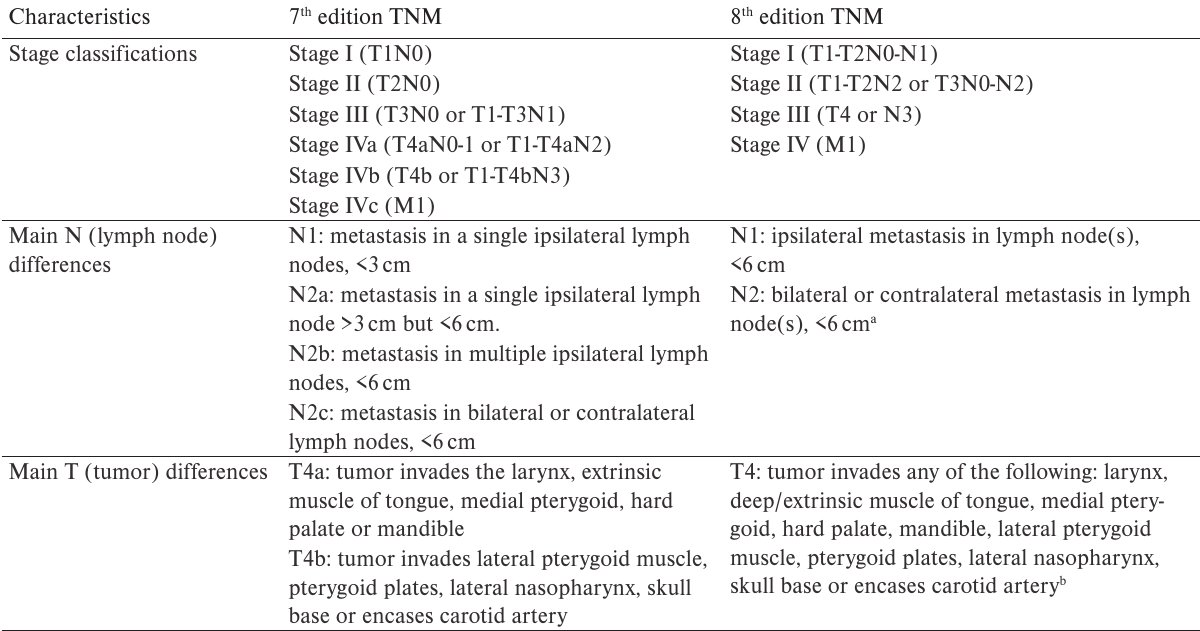
Table 2. New TNM staging system classification for HPV-related OPSCC patients 8th edition, developed by The International Collaboration on Oropharyngeal Cancer Network for Staging (ICON-S).